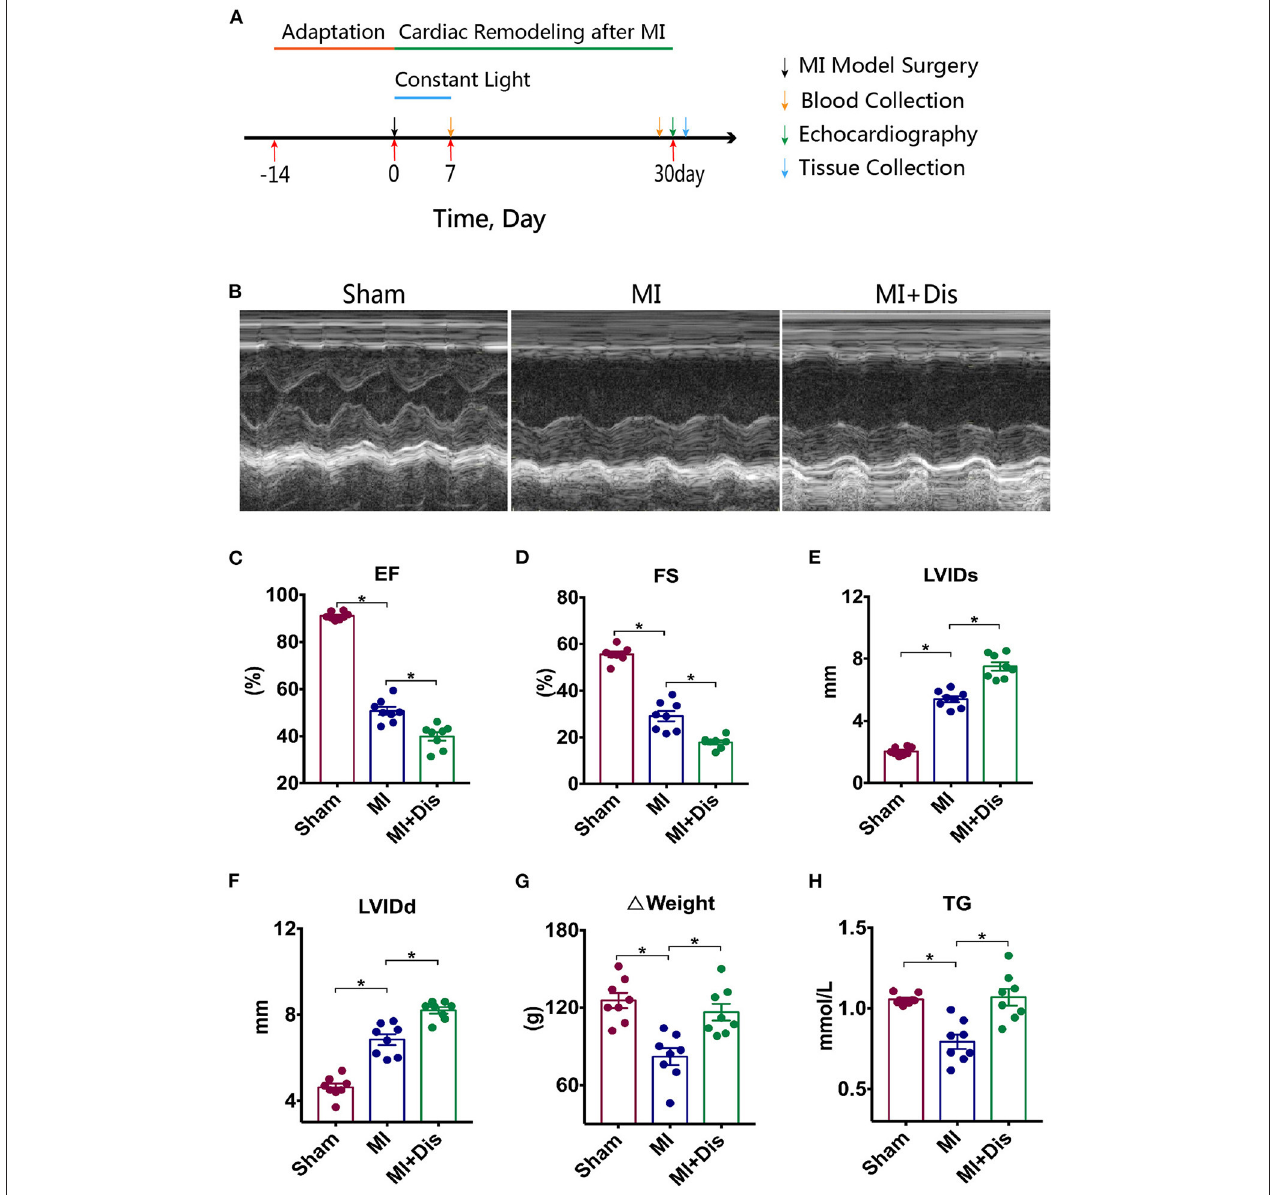
FIGURE 1 | Cardiac function and structure were aggravated by circadian disruption after MI. Experimental protocol is outlined in (A) . Representative images of echocardiography in all groups are shown in (B) . (C–F) Differences of EF, FS, LVIDs, LVIDd among three groups. (G) 1 weight (weight gain over the 30 days